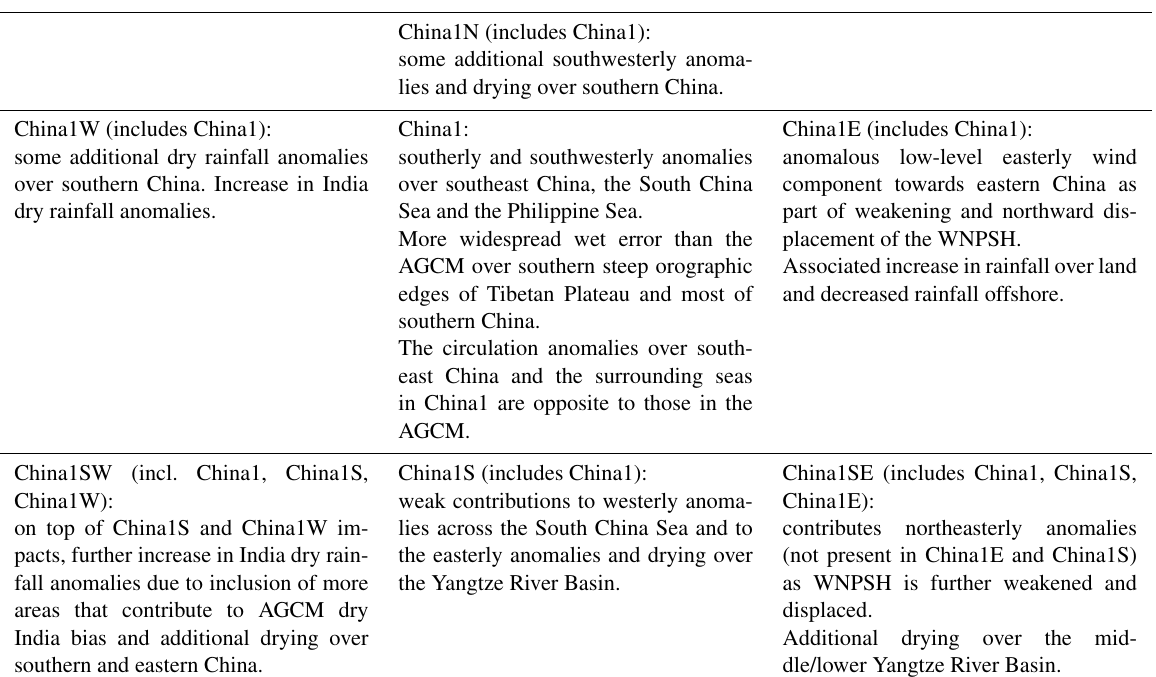
Table 2. Summary of the errors developing within the China1 domain of the RCM and the effects of extending the domain boundaries on either side of the China1 domain compared with the effects of China1 itself, as shown in Fig.